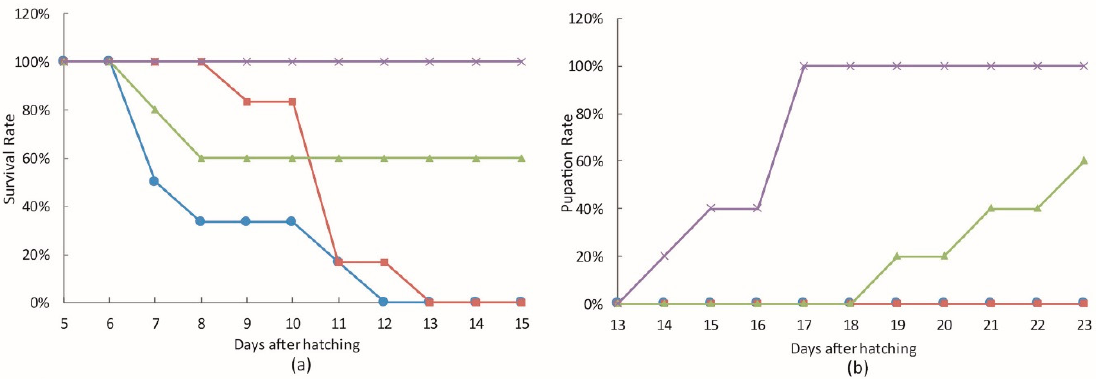
( b )) with real-time PCR. egfp gene in AcEGFP genome was used as the amplification target, and cellular tubulin gene was used as the control. The mean of three or more replicates was shown, with the error